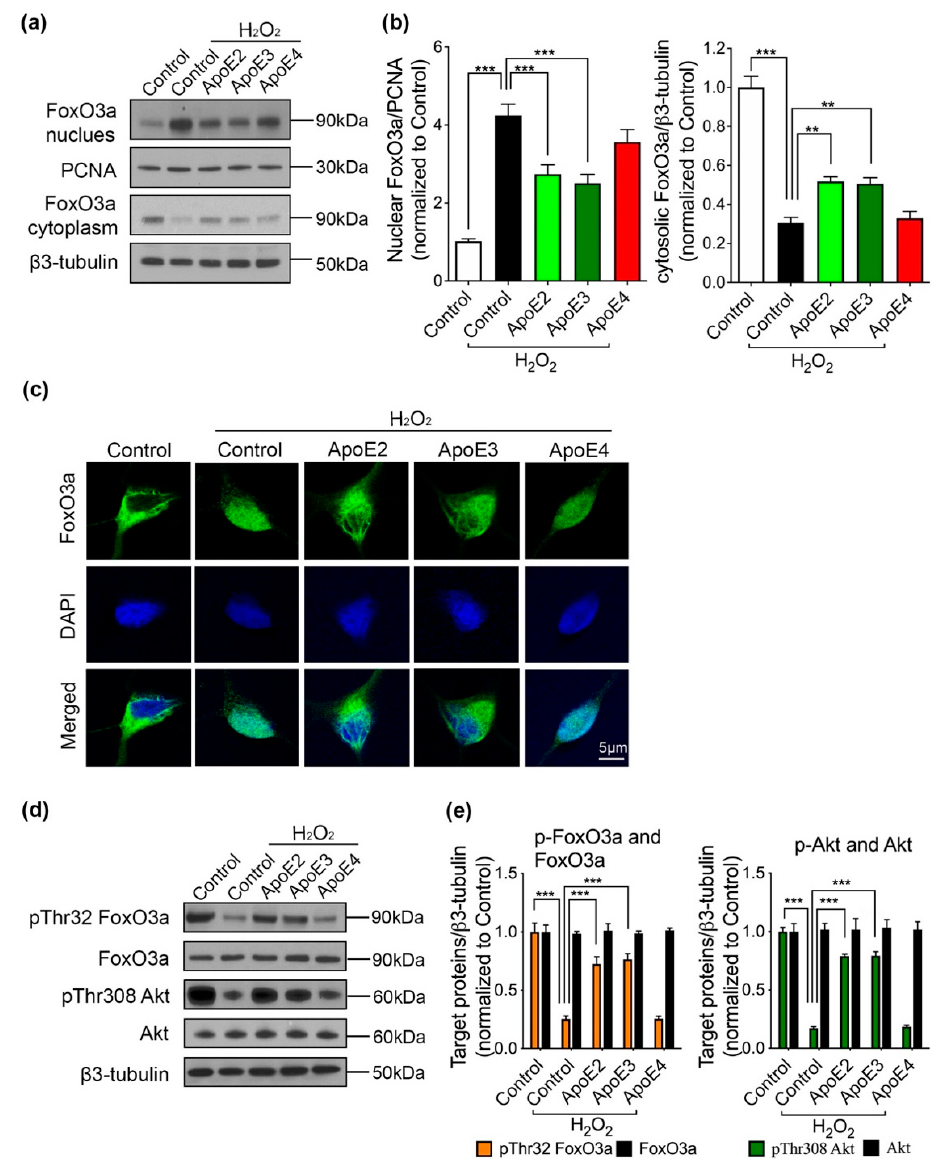
Figure 4. ApoE2 and ApoE3 regulate Akt/FoxO3a signaling pathway in response to H 2 O 2 . ( a , b ) Both nuclear and cytosolic FoxO3a protein expression levels were measured by Western blot and quantitative analysis was performed. Equal loading and protein transference were checked by detection of β 3-tubulin and proliferating cell nuclear antigen (PCNA) for cytosolic and nuclear extracts, respectively. ( c ) Representative immunofluorescence images exhibiting the translocation of FoxO3a in neurons under different conditions. White scale bar, 5 μ m. ( d , e ) Expression levels of phosphorylated FoxO3a (pThr32) and Akt (pThr308) were detected by Western blot with specific antibodies and quantitative analysis was performed. Total FoxO3a and Akt were also measured as reference. n = 4 per line, data are presented as a summary of all lines (mean ± SEM) using one-way ANOVA and Dunnett test. ** p < 0.01, *** p < 0.001 versus neurons co-treated with control medium and H 2 O 2